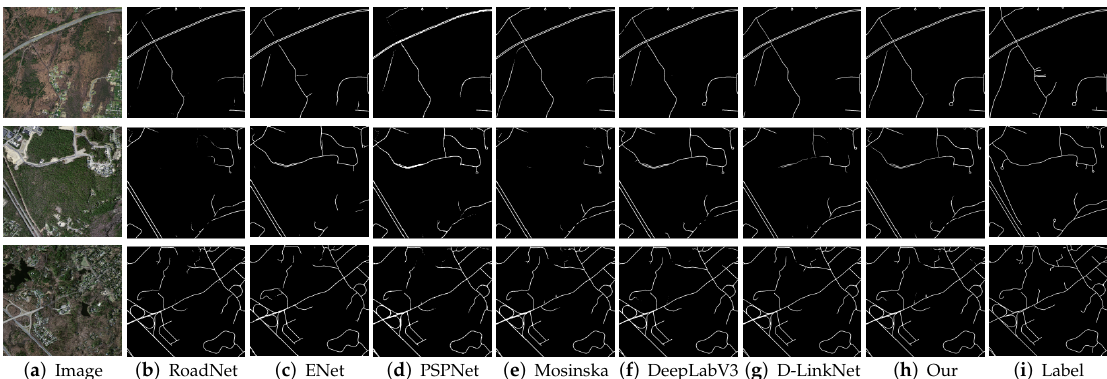
Figure 12. Performance comparison of student networks based on different methods with the Massachusetts Dataset. ( a ) Image; ( b ) results of RoadNet [18]; ( c ) results of ENet [33]; ( d ) results of PSPNet [34]; ( e ) results of Mosinska [20]; ( f ) results of DeepLabV3 [35]; ( g ) results of D-LinkNet [11];